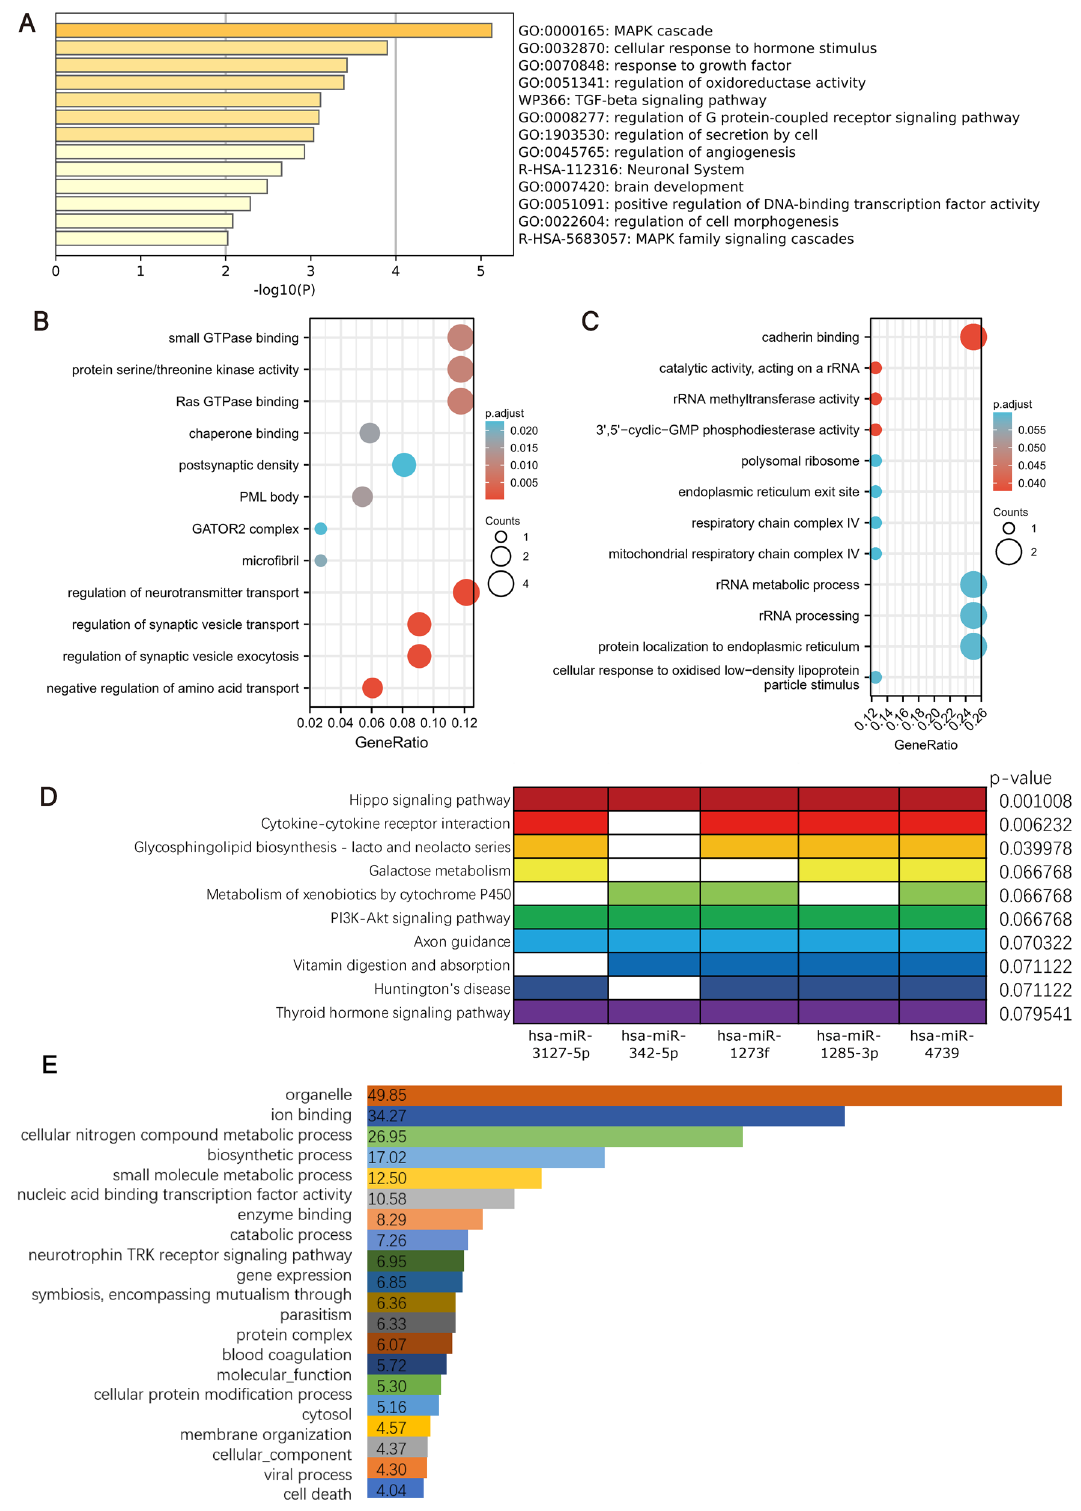
Figure 6. Enrichment analysis of target genes, target miRNAs, and DECs. ( A , B ) Enrichment analysis of the target genes. ( C ) Enrichment analysis of the host genes of target circRNAs. ( D , E ) Enrichment analysis of the target